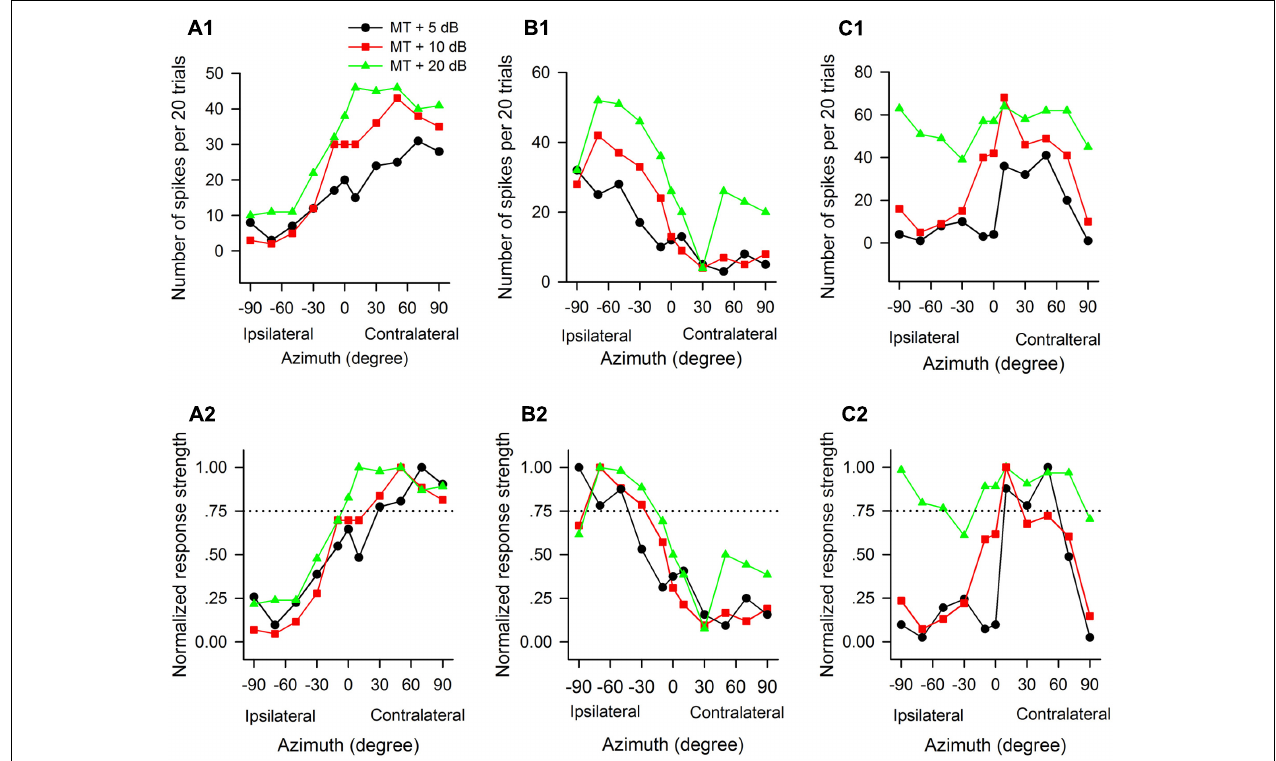
FIGURE 4 | The azimuth functions of three representative AI neurons vary with the change of sound stimulus levels. The data in each column are from one neuron. (A1–C1) Azimuth functions shown in number of spikes per 20 trials. (A2–C2) Azimuth functions shown in normalized response strength. MT, minimum threshold of the neuron. Curves with different symbols are the azimuth functions determined at the sound levels of MT + 5 dB, MT + 10 dB, and MT + 20 dB, respectively (see the legend in A1 ). The CF (kHz) and MT (dB SPL) of the three neurons are as follows: (A1,A2) 13.0 kHz, 35 dB SPL; (B1,B2) 34.1 kHz, 30 dB SPL; (C1,C2) 35.0 kHz, 20 dB SPL, respectively. Note that the azimuth functions and the azimuth preferences of the three neurons varied with the change of sound